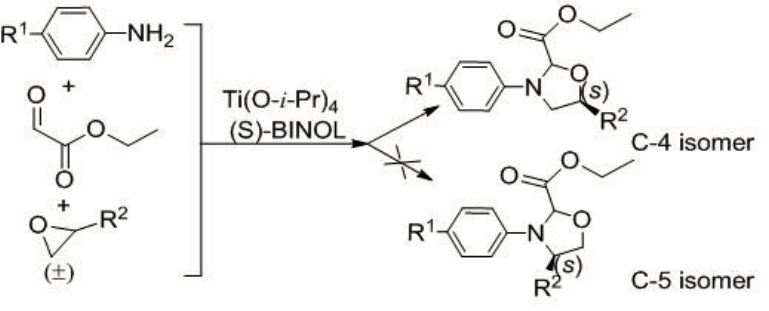
Figure 2. Isomer characterization of the